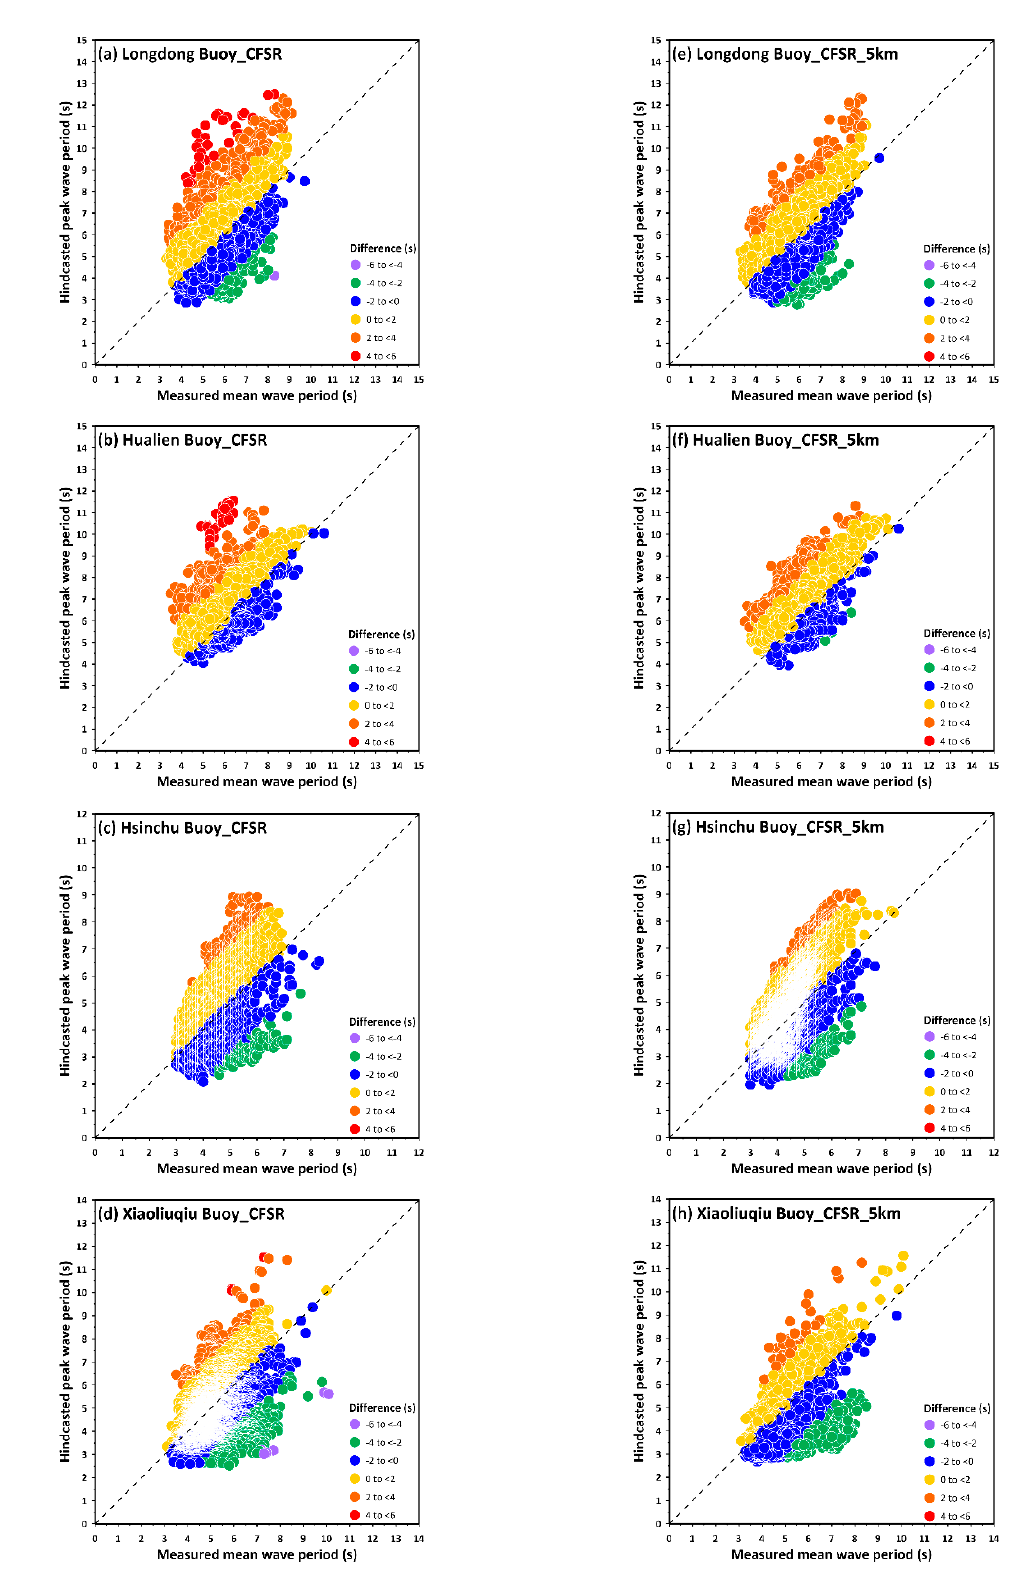
Figure 5. Scatter plots of the hindcasted versus measured peak wave periods for the ( a , e ) Longdong, ( b , f ) Hualien, ( c , g ) Hsinchu and ( d , h ) Xiaoliuqiu buoys using the ( a – d ) CFSR and ( e – h ) CFSR_5km winds.